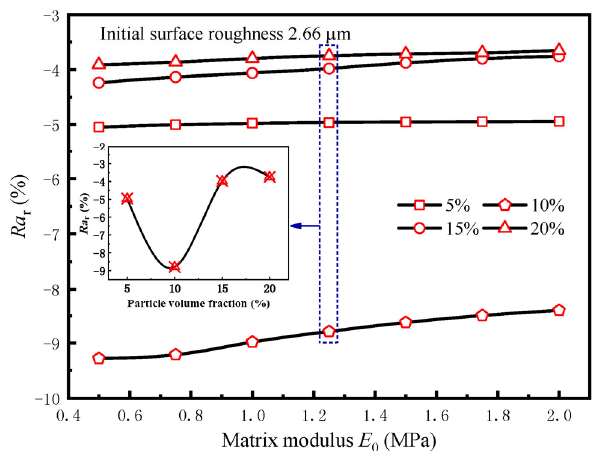
Fig. 8 Field-induced surface roughness of MREs as a function of matrix modulus for different particle volume fractions of 5%, 10%, 15%, and